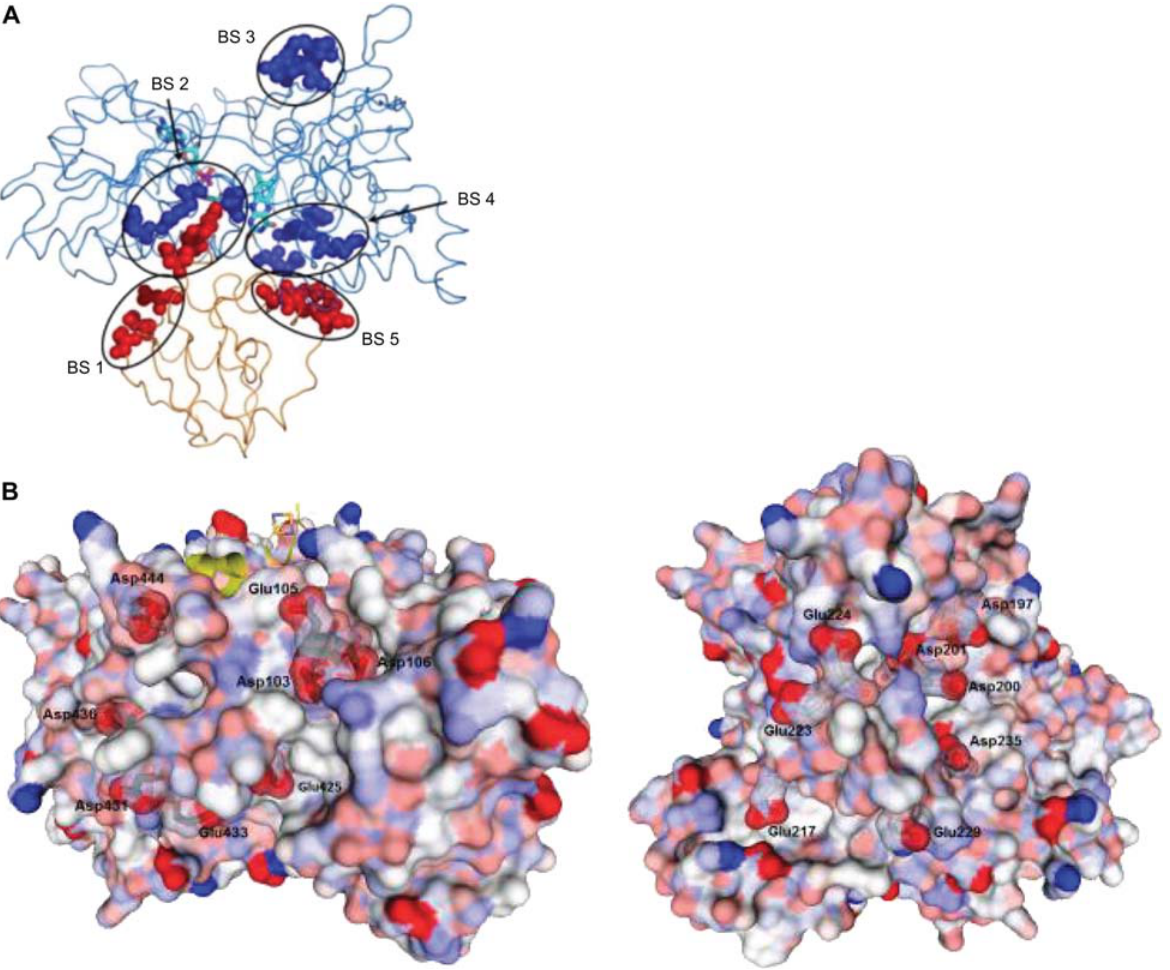
Figure 5 Structures of the Adx-AdR complex and the CYP11A1 surface. (A) Location of the identified binding sites (BS) on the Adx-AdR complex. Adx is shown in orange, AdR in light blue. For both proteins, a ribbon representation is used except for the residues lining the binding sites (blue: AdR residues, red: Adx residues) that are shown as ball-and-stick models and FAD (colorized representation, colorized by element). Reprinted from Berwanger et al. (23), with permission from Elsevier. (B) Surface view of CYP11A1. View on the negatively charged surface adjacent to the adrenodoxin binding site (residues Asp103, Glu105, Asp106, Glu425, Asp431, Glu433, Asp436 and Asp444) (on the left hand site) and apart from the adrenodoxin binding site (residues Asp197, Asp200, Asp201, Glu208, Glu217, Glu223, Glu224, Glu229, and Asp235) (on the right hand site) of CYP11A1 (coordinates taken from PDB ID 3NAO). Negatively charged amino acid residues are depicted in red, positively charged ones in blue. Amino acid residues forming a negative channel are labeled. The iron-sulfur cluster and the interaction domain of adrenodoxin are depicted in yellow. The visualization of the structures was performed using the program Discovery Studio Visualizer 2.5.5 from Accelrys (http://